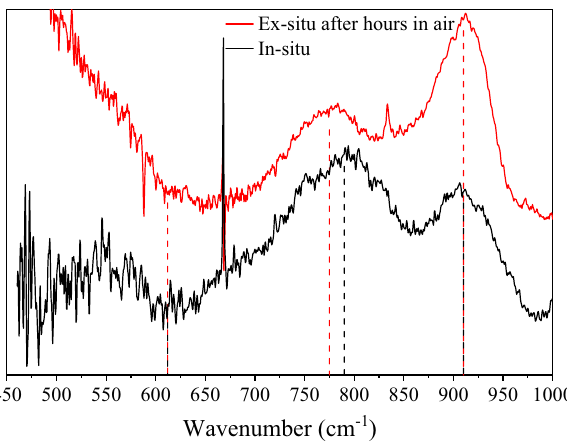
Figure 9. FTIR spectra of collected particulates after ablation of uranium in 100% O 2 measured in situ (black) and ex situ after hours in air (red). The uranyl symmetric stretching mode located at 790 cm −1 shifts to 775 cm −1 with the other modes appearing to be unaffected. The new location of this feature is consistent with that commonly reported in literature. Spectra are offset for